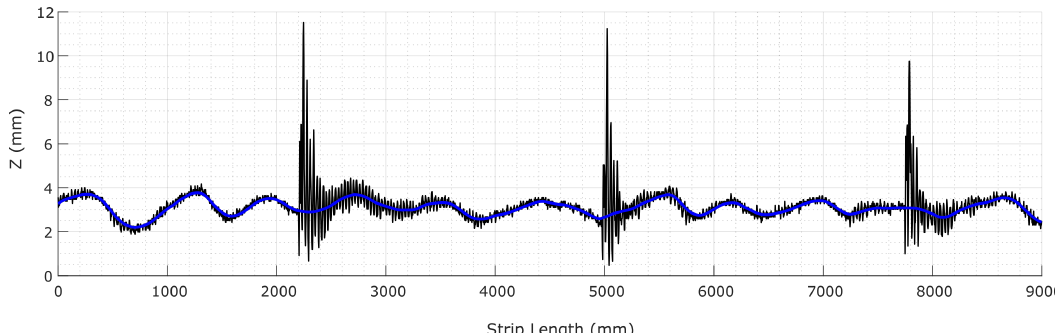
Figure 13. An instance of longitudinal fiber reconstruction (light blue line) by Hermite interpolation from the raw data of Figure 11 (dark